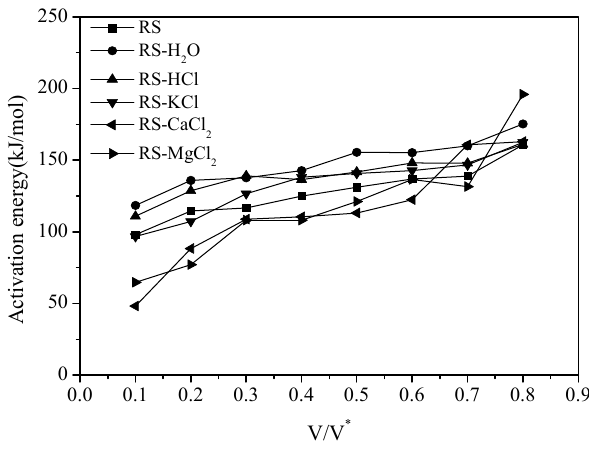
Figure 3. Activation energy curves with different V/V *.